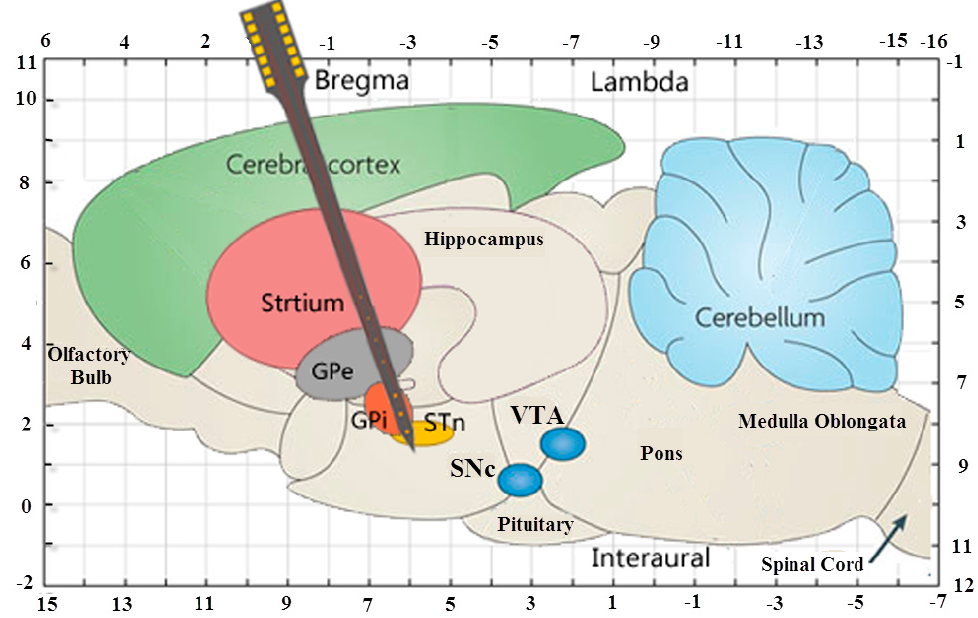
Figure 1. Schematic diagram of median sagittal plane of Sprague-Dawley rat brains showing the relative positional relationship of the STN, GPi and striatum (coordinate unit: mm).